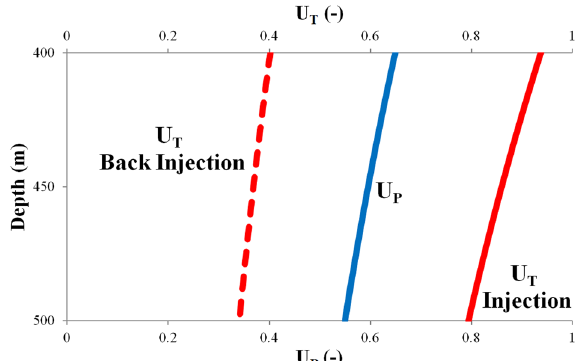
Fig. 12 U T and U P in the injection and in the back injection in the aquifer. U P is the same in the two different stages